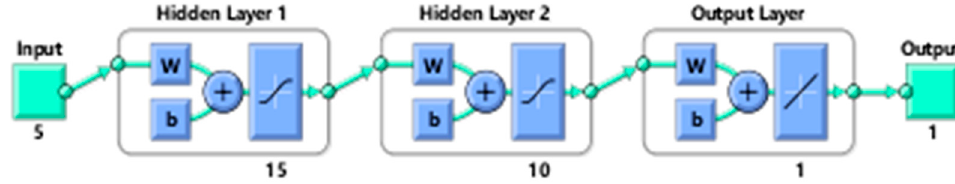
Figure 1. Topology of the best ANN network (5-15-10-1).